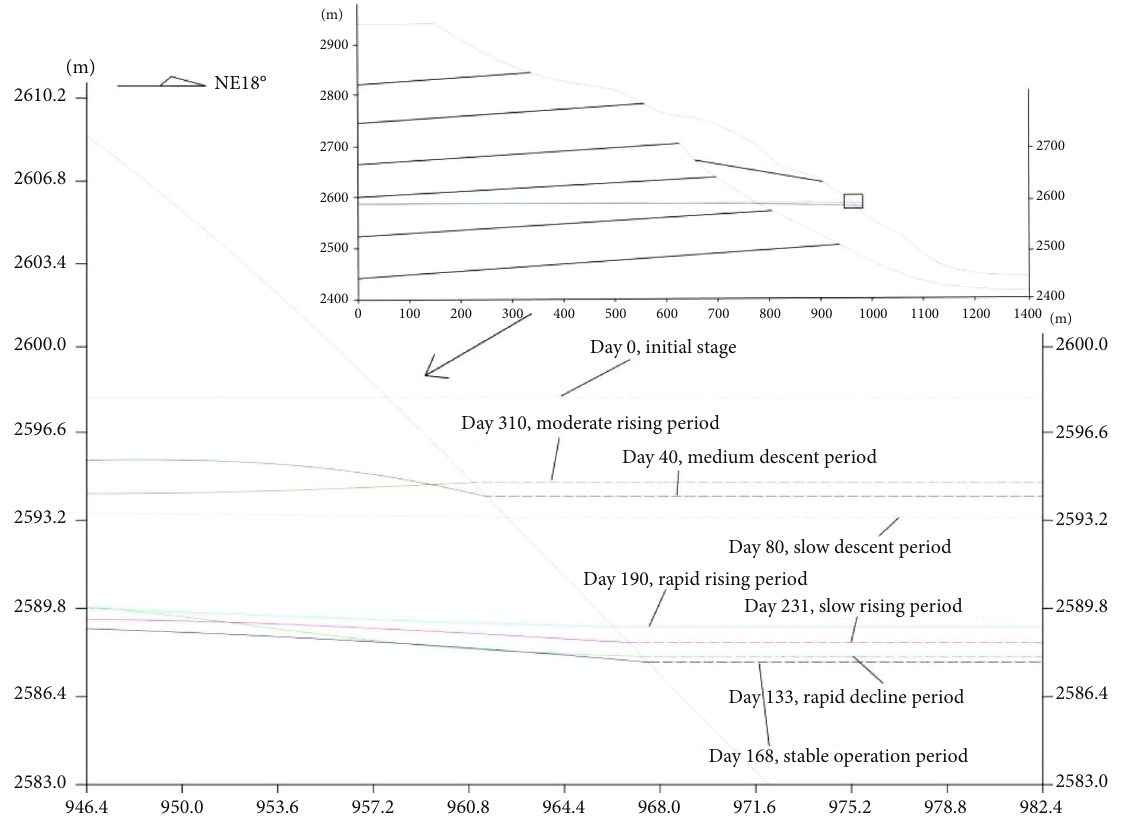
Figure 7: Phreatic line of Chana landslide at di ff erent